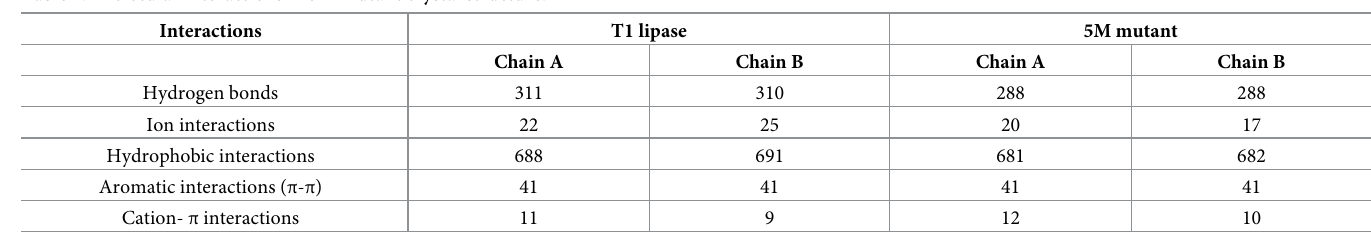
Table 2. Molecular interactions in 5M mutant crystal structure.